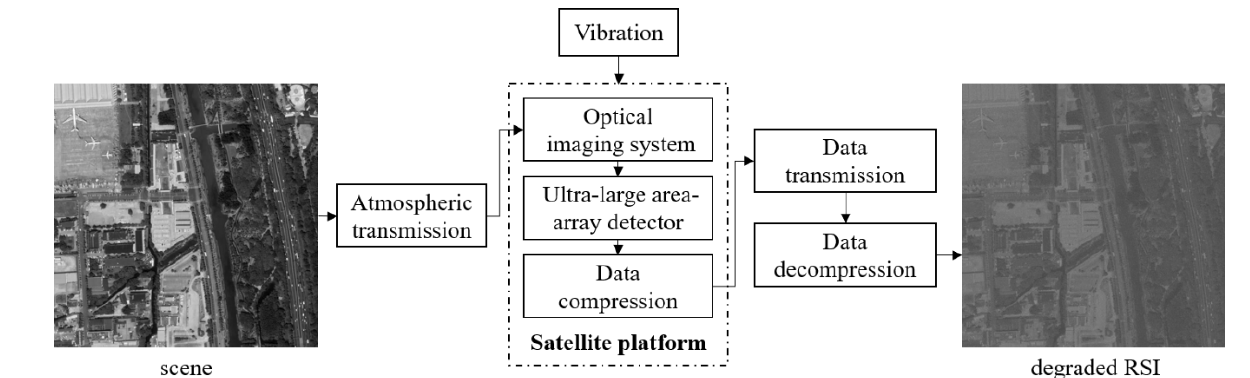
Figure 4. Optical remote sensing chain imaging simulation process.